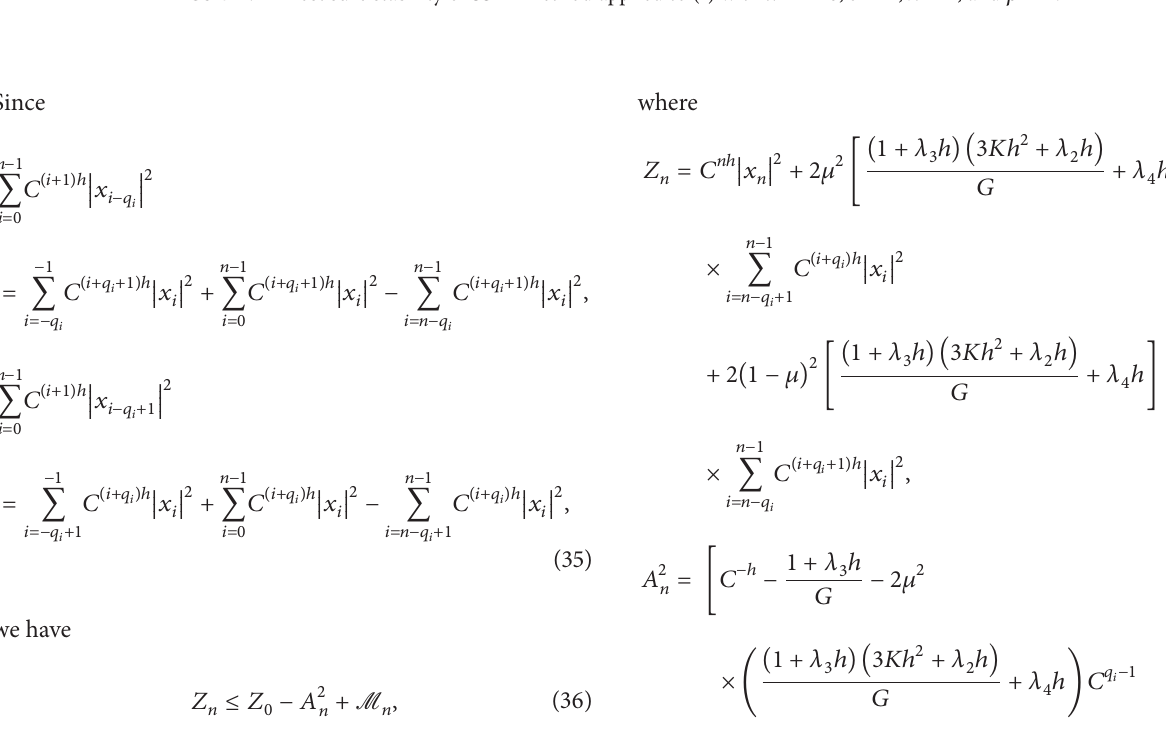
Figure 1: Almost sure stability of SSBE method applied to (1) with 𝛼 = −10 , 𝜎 = 1 , 𝜆 = 1 , and 𝛽 = 2